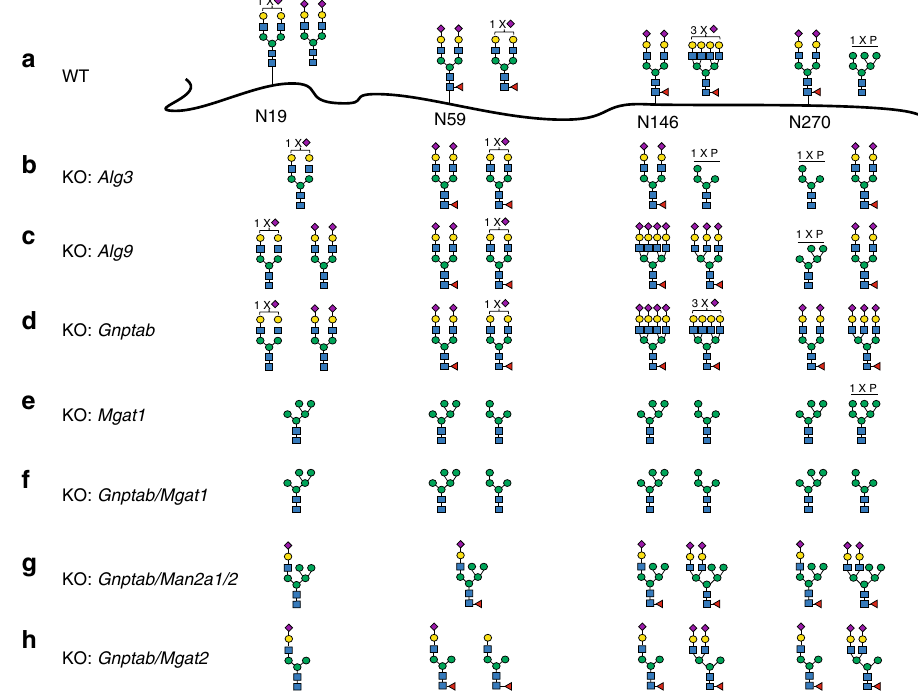
Fig. 4 Site-speci fi c glycan analyses of β -glucoscerebrosidase (GBA) glycoforms produced in knockout (KO) CHO cells. a The two most abundant glycan structures at N-glycosites (N19, N59, N146, and N270) of GBA produced in CHO wild type (WT) are shown, and b – h the two most abundant glycans for GBA produced in engineered CHO clones are shown as indicated. Each glycan structure was con fi rmed by targeted tandem mass spectrometry (MS/MS) analysis. Details regarding the stacking ancestry, sequence analysis, and N-glycans pro fi ling are shown in Supplementary Tables 3 and 4, and Supplementary Fig. 4,